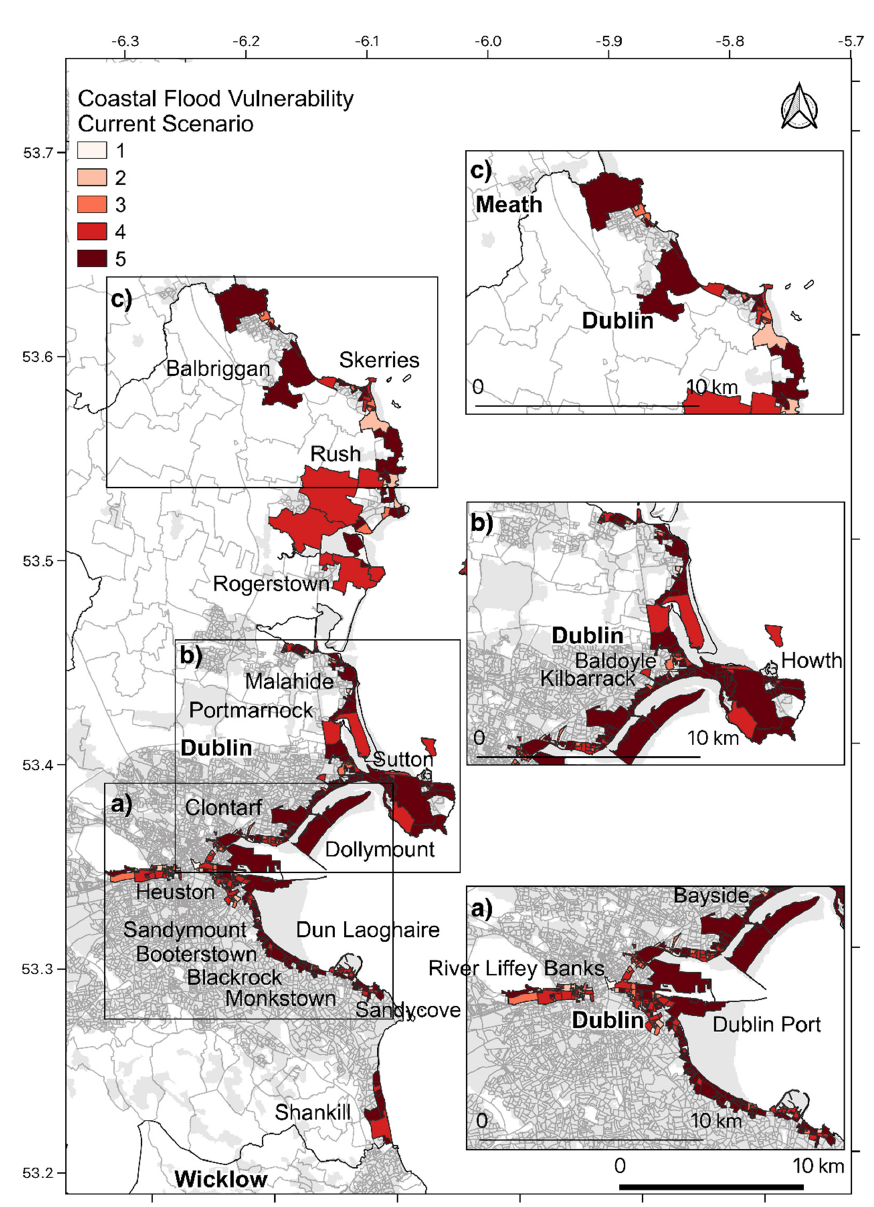
Figure 6. Vulnerability index (V) across Dublin County for the current period. The index ranges from 1 (very low vulnerability) to 5 (very high vulnerability). Panel information is shown in Figure 3. Disaggregating the components, it appears that the more disadvantaged areas from a socioeconomic point of view are those around the inner parts of the core city centre along the River Liffey Banks. This is also confirmed by the Pobal HP Deprivation Index which measures the relative affluence or disadvantage of all SAs around Ireland based on soci- oeconomic variables [81]. Areas close to Dublin Port and River Liffey and Tolka Estuaries (e.g., Clontarf) up north to Howth and down to Sandymount, Booterstown up to Dun